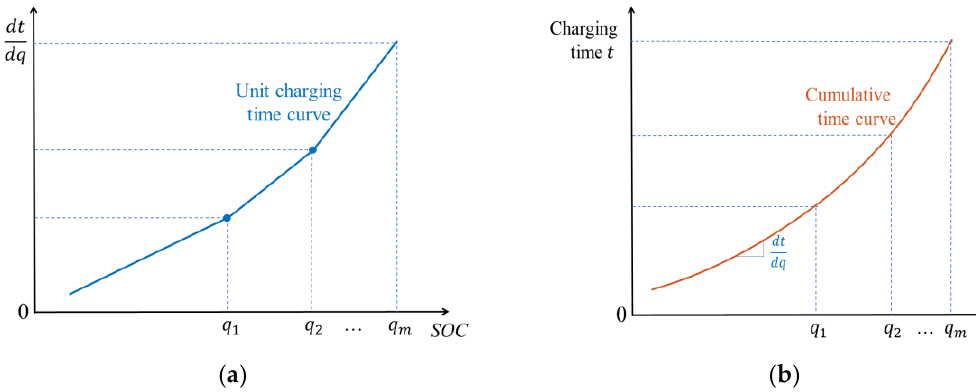
Figure 4. Performances of charging times with current battery power levels: ( a ) curve of the varying SOC ( 𝑞 ) and the battery charging rate ( 𝑑𝑡/𝑑𝑞 ); ( b ) cumulative time curve of the SOCs of batteries.